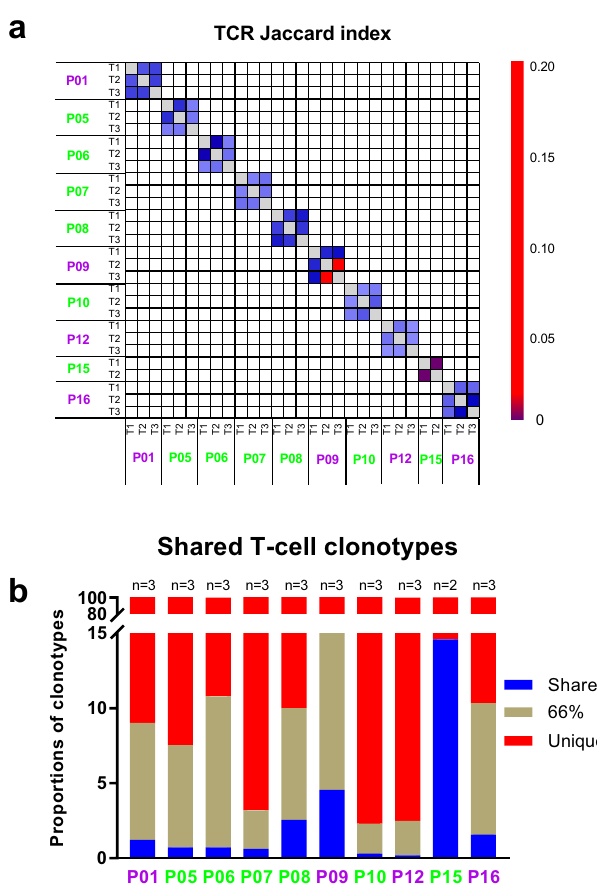
Fig. 4 Substantial T cell receptor (TCR) repertoire intratumor heterogeneity (ITH) in small-cell lung cancer (SCLC). a Quanti fi cation of TCR ITH by Jaccard index (JI), a metric representing the proportion of shared T-cell clonotypes between two samples in 10 SCLC patients with multiregion TCR sequencing data. b Proportions of T-cell clonotypes detected in all regions (shared, blue), in 2/3 (brown) and restricted to a single region (red) from the same tumors in 10 SCLC patients with multiregion TCR sequencing data. Patient ID: purple = alive; green = deceased. Source data are provided as a Source Data fi